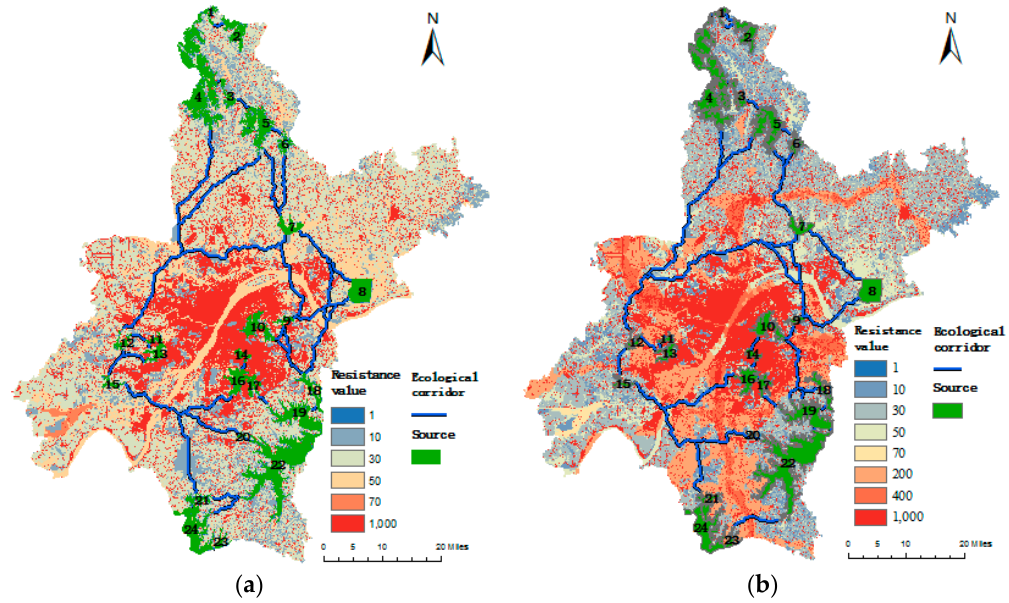
Figure 7. Network maps under different situations. ( a ) Scenario 1 Corridor Network; ( b ) Scenario 2 Corridor Network.